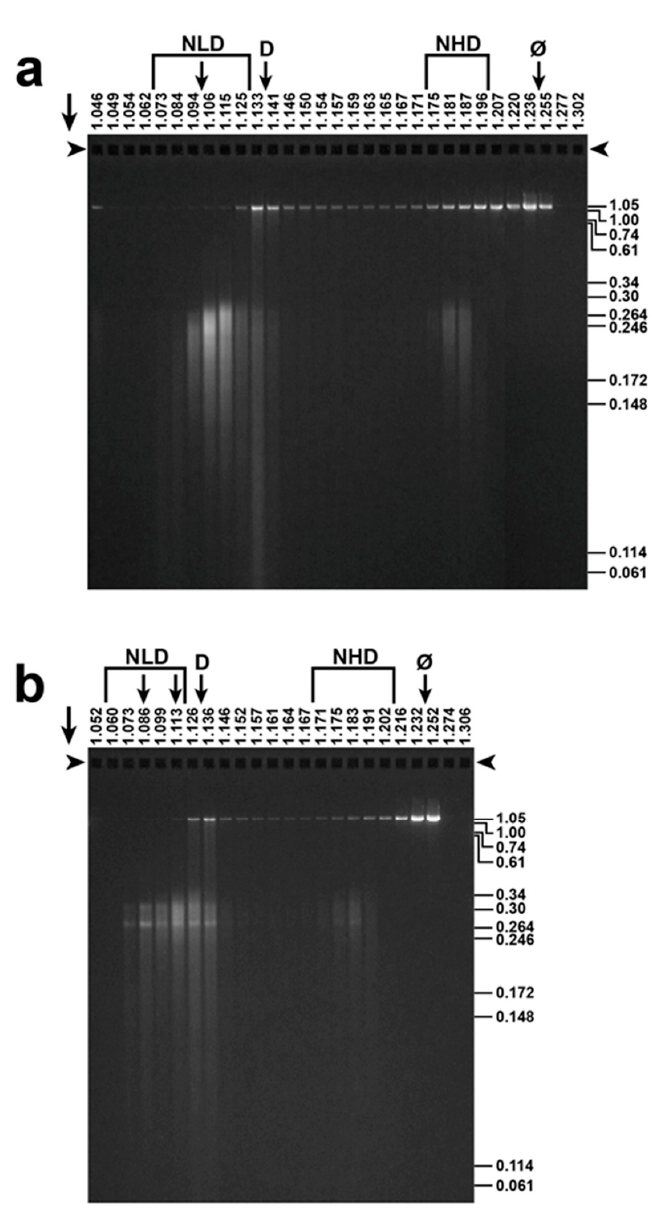
Figure 4. Final fractionation and detection of T3 ipDNA-capsids. After buoyant density centrifugation in a Nycodenz density gradient, the ipDNA of ipDNA-capsids with peak F values of ( a ) 0.23–0.27 and ( b ) 0.27–0.30 was expelled and was analyzed by agarose gel electrophoresis. F values, indicated at the right, were determined via co-electrophoresis of the length standards of [15]. Arrows above an arrowhead indicate electrophoretic direction; arrowheads indicate origins; NLD: Nycodenz low density; NHD: Nycodenz high density; D: free DNA, Ø: Infective phage